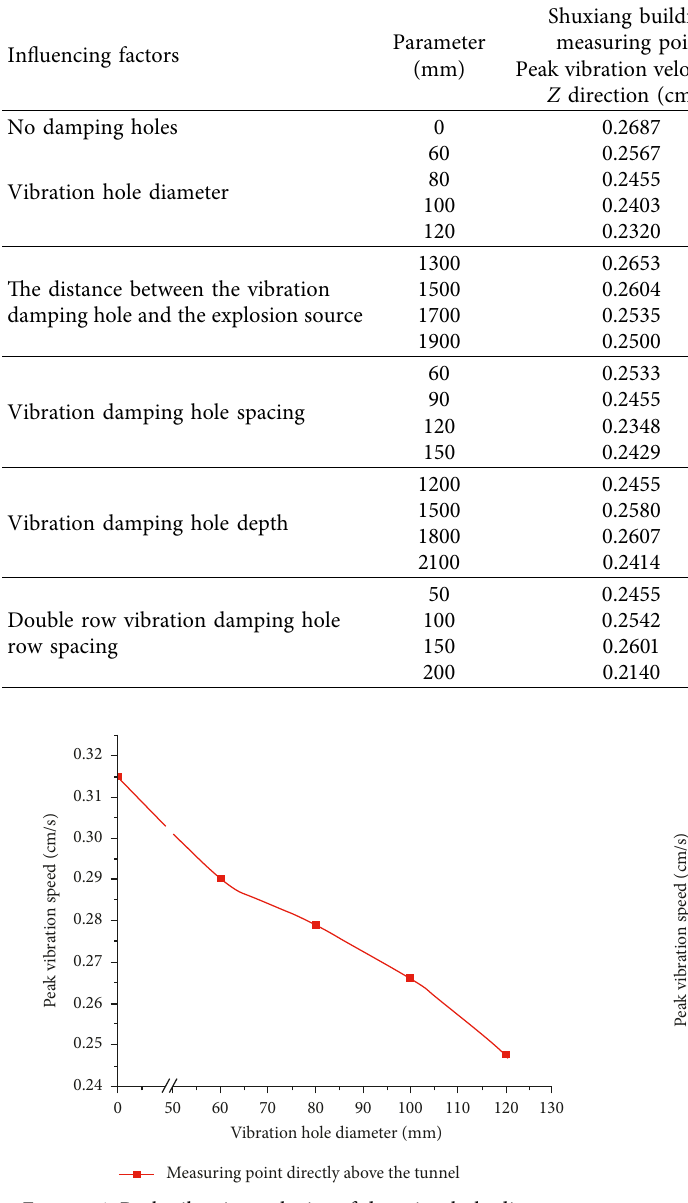
Table 5: Summary table of the peak vibration speed in the Z direction of each influencing